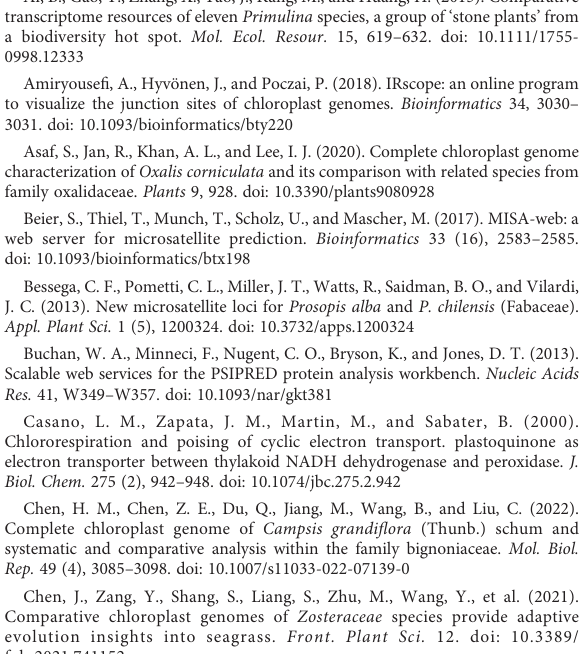
SUPPLEMENTARY FIGURE 1 ThecomparisonofeachtypeofSSRsamong12 Paraboea choloplastgenomes. SUPPLEMENTARY FIGURE 2 Number of the four complex repeat types (forward, palindrome, reverse, and complement) in the twelve Paraboea chloroplast. SUPPLEMENTARY FIGURE 3 Protein secondary structure of ndh F. SUPPLEMENTARY FIGURE 4 Protein secondary structure of ycf1 . SUPPLEMENTARY TABLE 1 Chloroplast genome sequences from GenBank used in this study. SUPPLEMENTARY TABLE 2 Summary of SSRs in twelve Paraboea chloroplast genomes. SUPPLEMENTARY TABLE 3 Summary of complex repeats in twelve Paraboea chloroplast